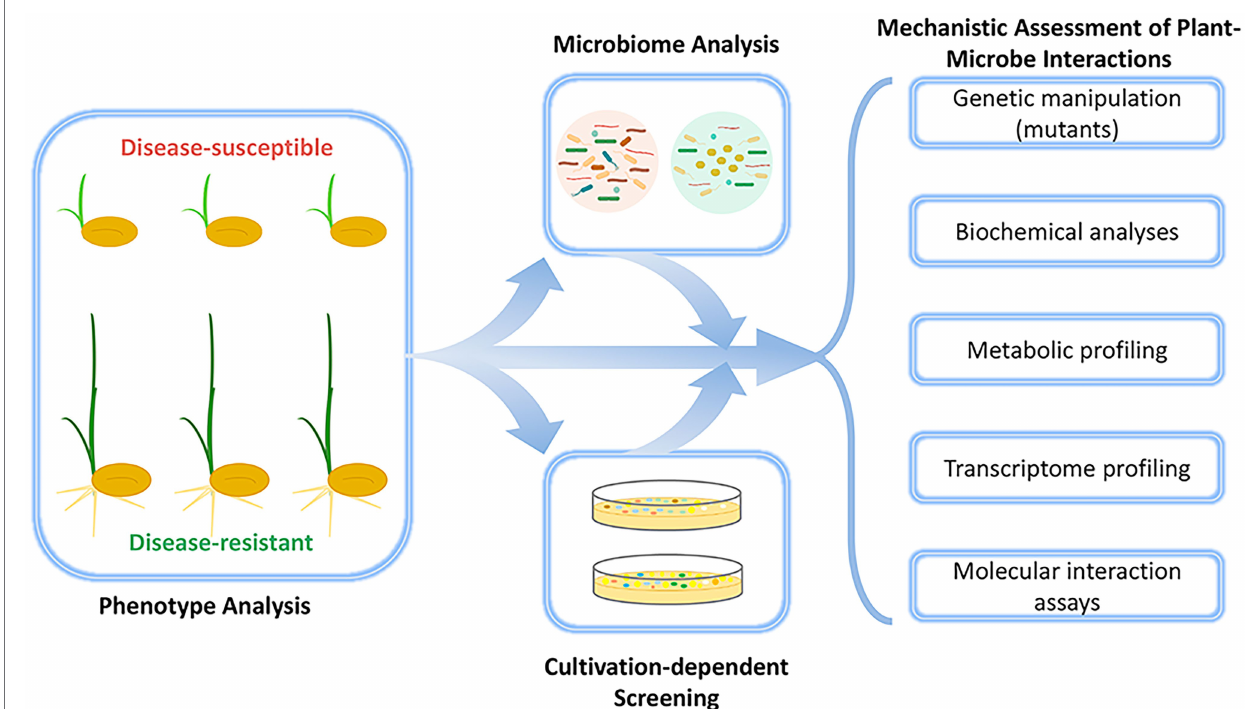
FIGURE 1 | Schematic workflow of the integrative approach that led to the discovery of the first seed-endophytic bacterium that confers holistic disease resistance to rice plants. Its discovery was facilitated by large-scale microbiome analyses that were complemented with a series of cultivation-dependent and-independent experiments. The approach led to the discovery of Sphingomonas melonis ZJ26 that shapes a disease-resistant rice